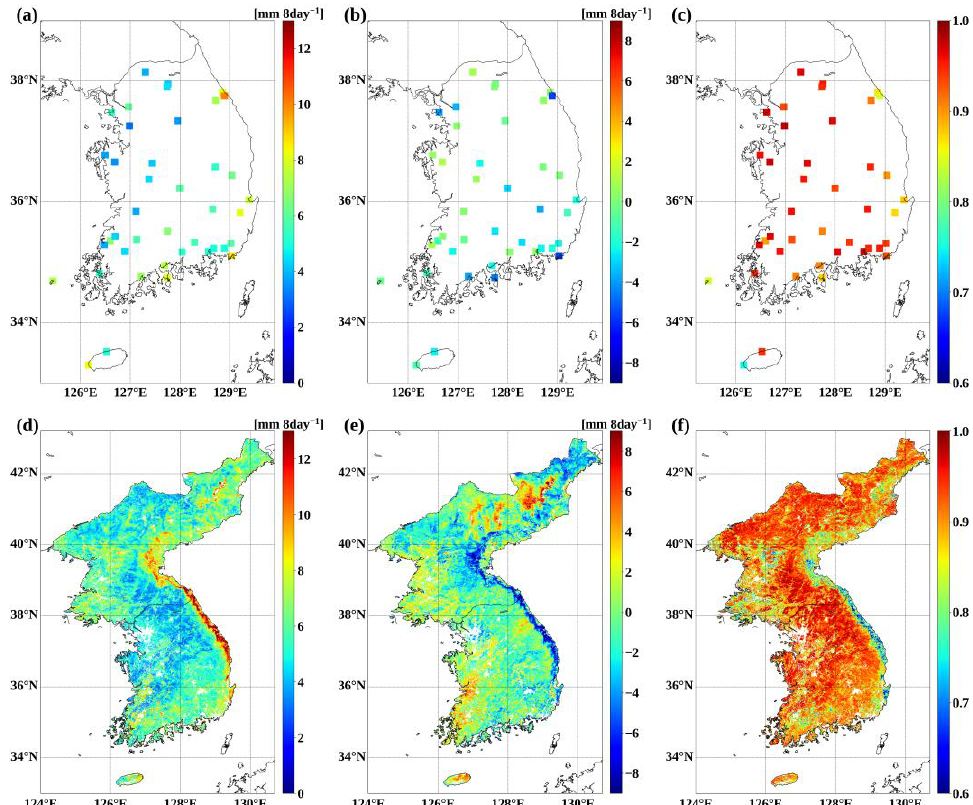
Figure 11. Accuracy of Terra/MODIS PET for the period 27 July 2020 to 27 July 2021 at ( a – c ) the ASOS stations operated by KMA, and ( d – f ) the coordinates of the GK2A/AMI satellite. The accuracy is represented by ( a , d ) RMSE, ( b , e ) bias, and ( c , f ) Pearson’s R . The KMA ASOS station-derived PM-ET data showed a Pearson correlation of